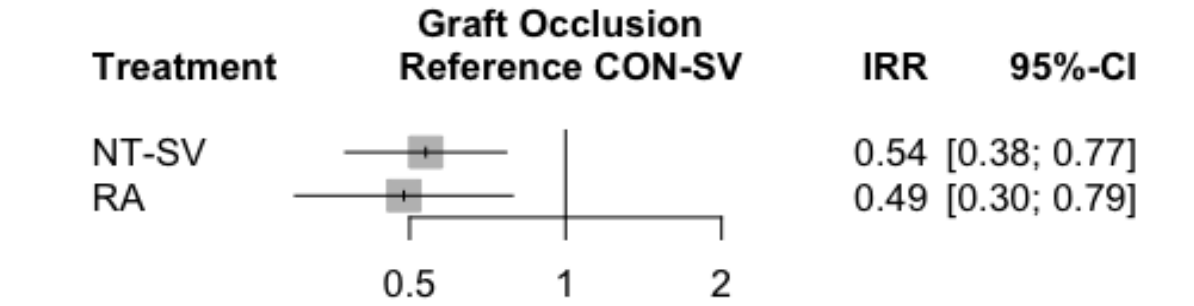
Fig. S4 - Sensitivity analyses for studies using computed tomography angiography exclusively for postoperative graft assessment. There were not enough studies reporting data for the right internal thoracic artery and the gastroepiploic artery. CI=confidence interval; CON-